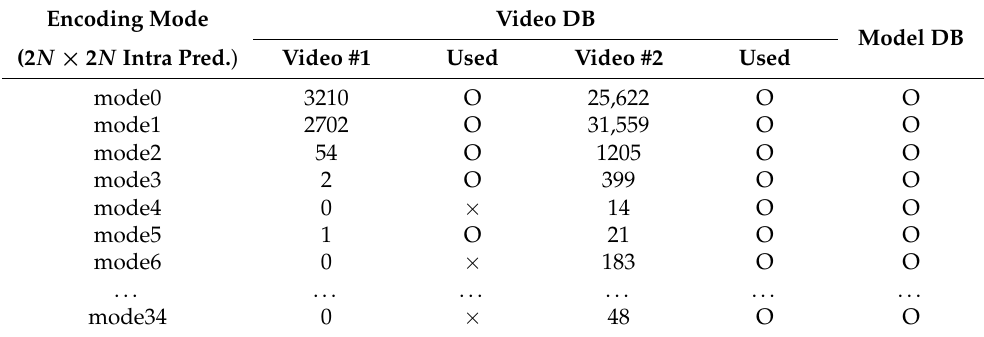
Table 7. Example of 2 N × 2 N intra prediction in 32 × 32 CU in HEVC. Here, descriptors from two videos shot by the same camera are not identical to each other. Here, O and × represent ‘used’ and ‘not used’,